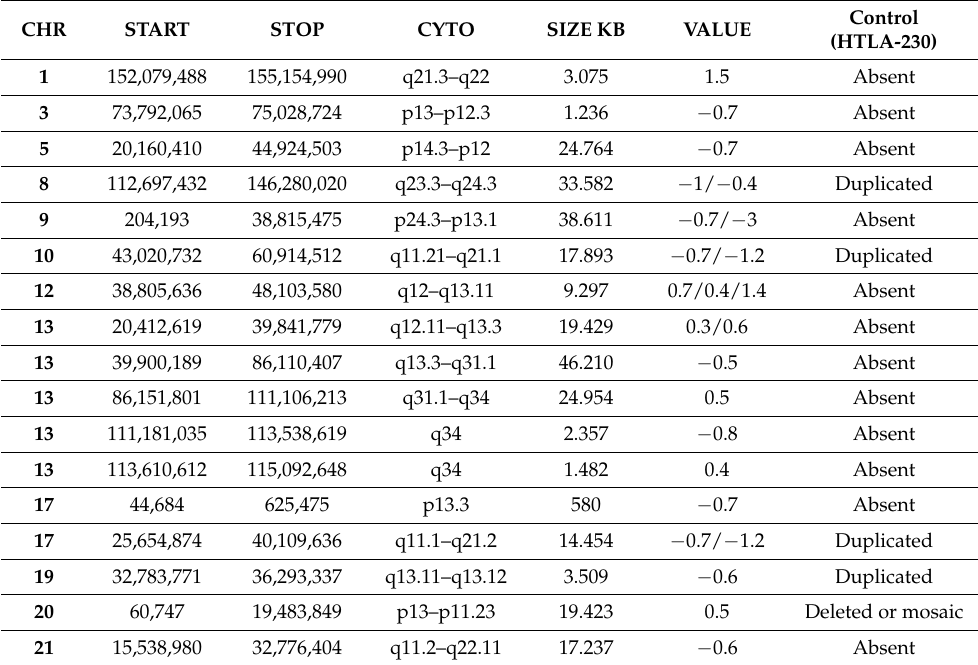
Table 2. CGH analysis on HTLA-ER cells in comparison to HTLA-230